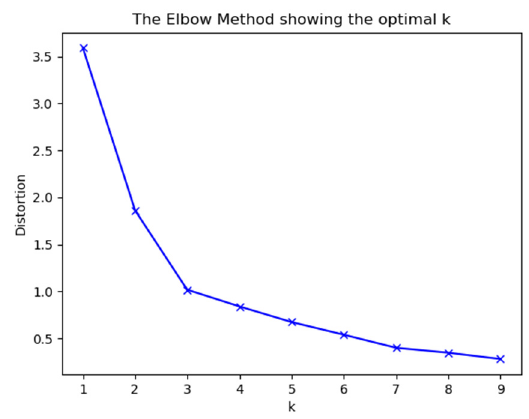
Figure 12. Optimal cluster number of elbow method.